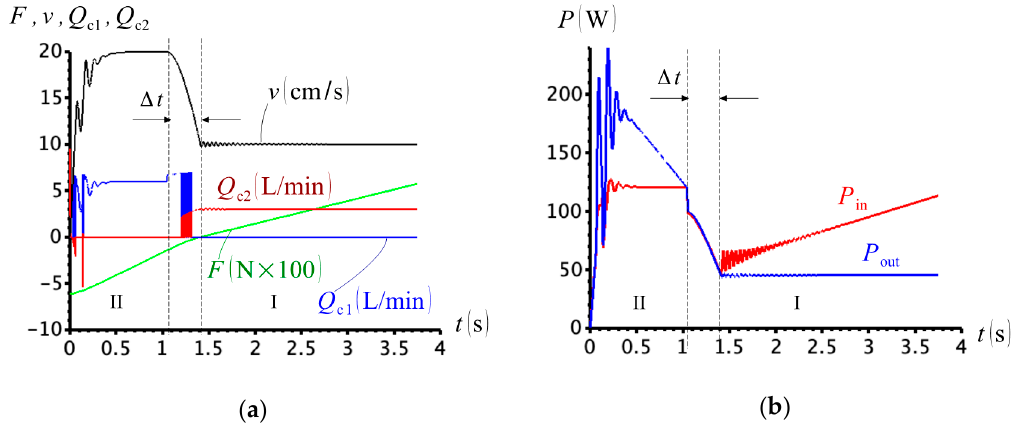
Figure 34. ( a ) External force, cylinder velocity and check valve flows; ( b ) input and output powers ( m = 250 kg ) .